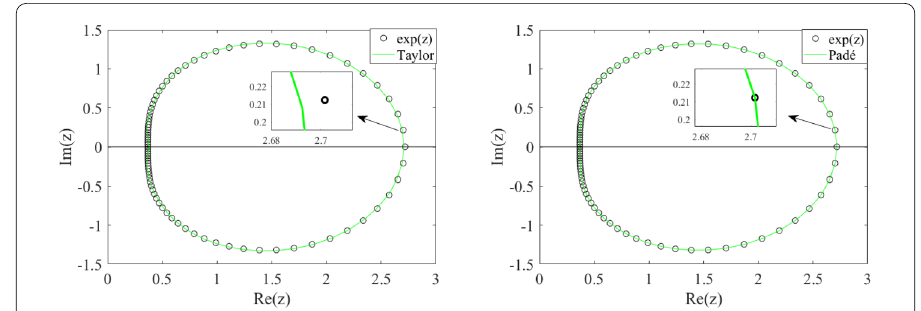
Figure 4 The stability regions of the Taylor approximation and Padé